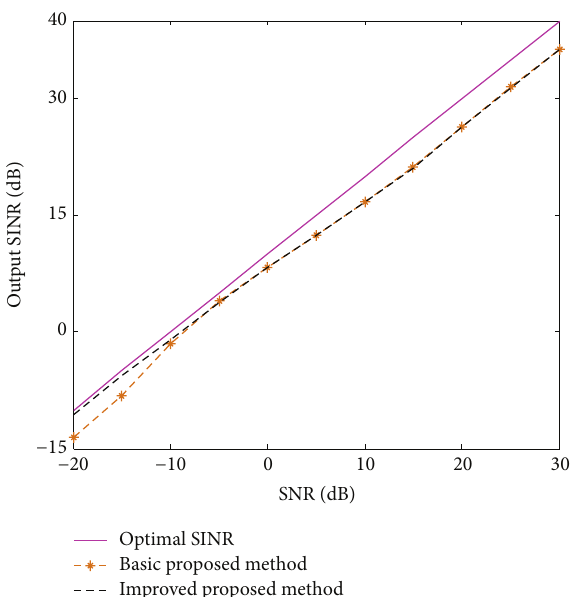
Figure 2: Output SINR of beamformers versus input SNR for the case of perturbations in antenna array geometry.